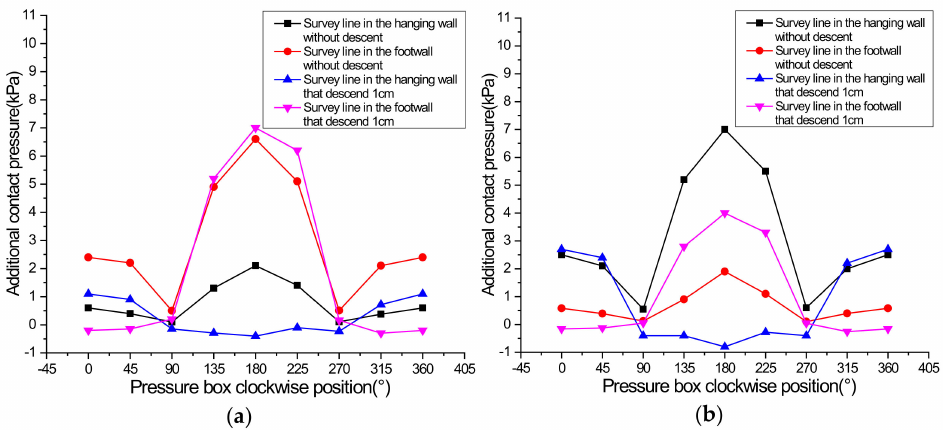
Figure 22. Distribution of the circumferential additional contact pressure: ( a ) vibration exciter at 60 cm; ( b ) vibration exciter at 100